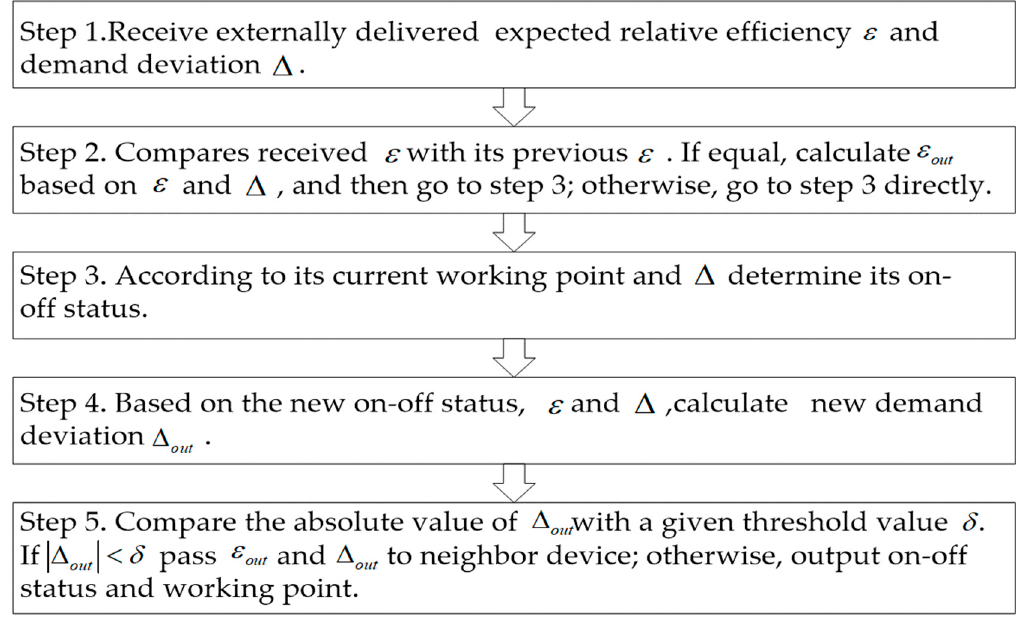
Figure 5. The flow chart of the device self ‐ organizing optimization control.